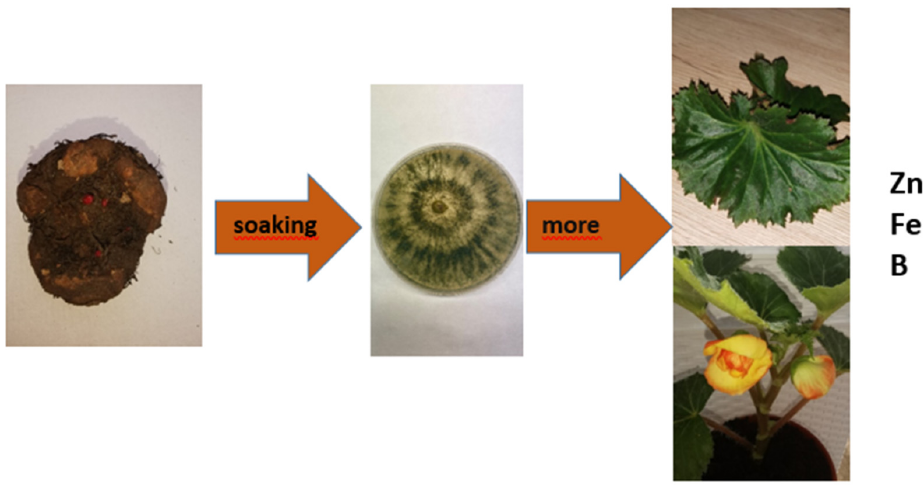
Figure 4. Effect of Trichoderma spp. on quality of Begonia × tuberhybrida ‘Picotee Sunburst’. Table 2. Effect of Trichoderma spp. on ornamental plants. Species Modifications